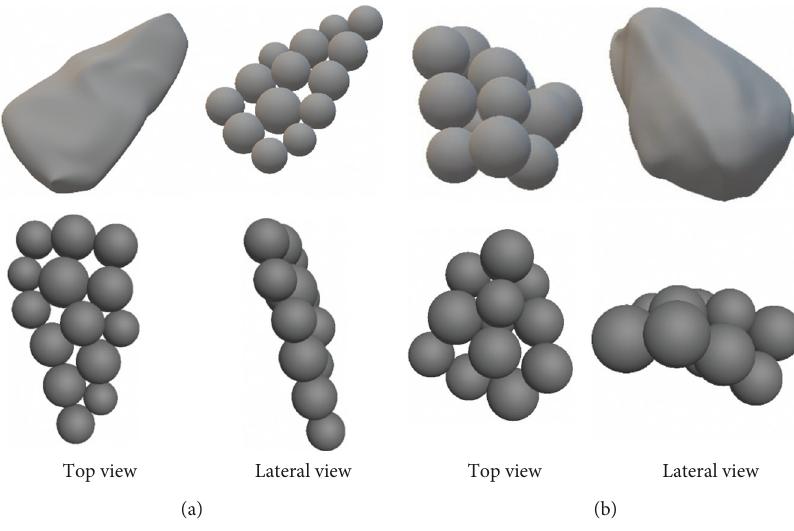
Figure 3: Shape-A agglomerate DEM model. (a) 14 spheres. (b) 12 spheres. Rough steel